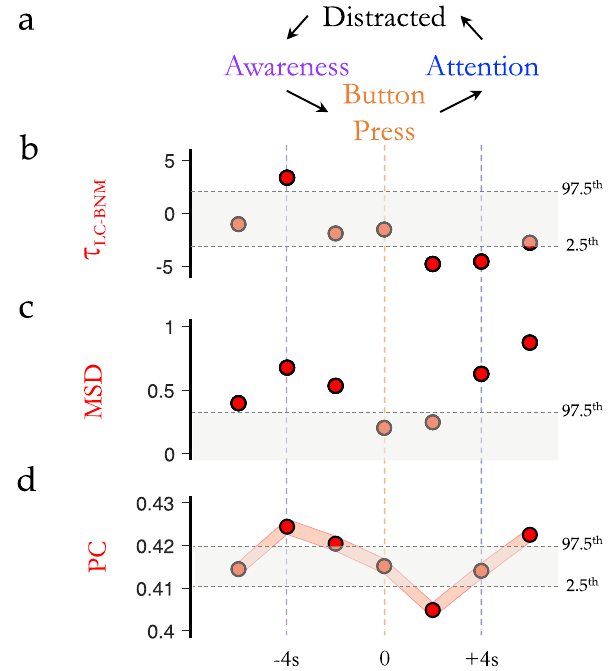
Fig. 3 Awareness of intrinsic state changes. a Participants performing breath-awareness meditation (focus; blue) were trained to respond with a button press (orange) when they became aware (purple) that they had become distracted (i.e. their attention had wandered from their breath) and to then re-focus their attention (blue) on their breath. b We observed a peak in τ LC (cid:1) BNM (red; LC relative to BNM BOLD activity) ~4 s before the button press, which then returned to low levels in the 2 – 4 s following the button press. c The mean-squared displacement (MSD; dark orange) of TR-to-TR BOLD signal was increased above null values around the peak in τ LC (cid:1) BNM , as well as following the re-establishment of attentional focus (in ( b , c ) grey shading depicts 95% CI of block-resampled null distribution). d We observed a peak in mean participation coef fi cient (PC) ~4 s (2 TRs) prior to the button press during the task. a – d Grey shading depicts mean- centred 97.5th and 2.5th percentile of block-resampled null distribution 5000 permutations, i.e. outside grey shading indicates a value different than null ( p < 0.05); and ( d ) red shading represents mean ± SEM across ( n = 400 parcels). Source data are provided as a Source Data fi